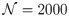
Statistical analysis of displacements for the random walk strategy defined in Eq (1).(a) Monte Carlo simulation of a discrete-time random walker that visits N=2000 specific locations in the region [0, 1] × [0, 1] in R2 following the random strategy given by Eq (1) with α = 3 and R = 0.01. The total number of steps is t = 200 and the scale in the color bar represents the time associated to each step. (b) Probability P(l) to find a displacement of length l, as a function of l, for different values of α. We analyze 106 displacements of the random walker visiting sites in the plane; the value of R is the same as in (a). The dashed lines represent the power-law relation P(l) ∝ l−α+1.